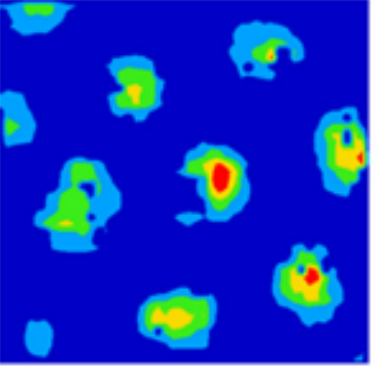
Figure 1. The activation field of a single grid cell (from [22]). Each grid cell module “represents” a small area around a given position, and has its specific spatial characteristics (the distance between 2 adjacent activation peaks of its grid cells called the spacing , and the absolute orientation to the physical space). The